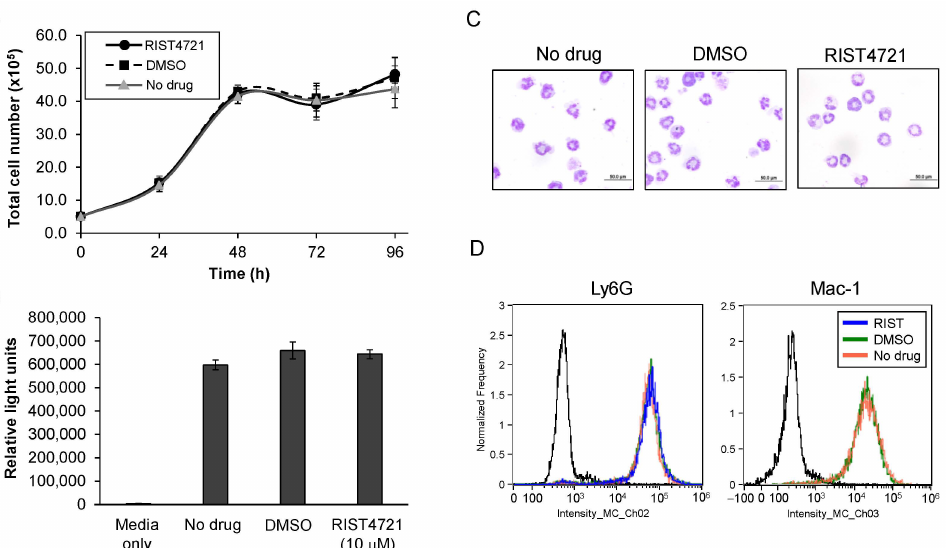
Figure 5. Proliferation and differentiation characteristics of neutrophils treated with RIST4721. ( A ) Graphed are total numbers of live cells identified by trypan blue exclusion in cultures treated with RIST4721 (10 nM) vs. two control conditions, DMSO (diluent) or no treatment (no drug). ( B ) Shown are levels of luminescence via CellTiter-Glo generated from mature neutrophils treated for 2.5 h with the concentration of RIST4721, shown to completely abrogate KC-mediated chemotaxis (10 µ M), vs. no drug or DMSO-only treatment. Luminescence levels from media plus CellTiter-Glo with no cells (media only) are also shown to indicate background. ( C ) Pictures of neutrophils derived from cultures with RIST4721 (10 µ M) vs. no drug or DMSO, each stained with Wright–Giemsa, indicate normal morphologic maturation with characteristic lobulated nuclei. ( D ) Graphed are results from flow cytometry analyses of neutrophils that were generated with RIST4721 treatment (20 nM RIST4721) vs. DMSO or no treatment, each labeled with fluorescence-labelled antibodies to either Ly6G or Mac-1. All graphed data are averages ± SD from triplicate tests per assay and represent data from three independent